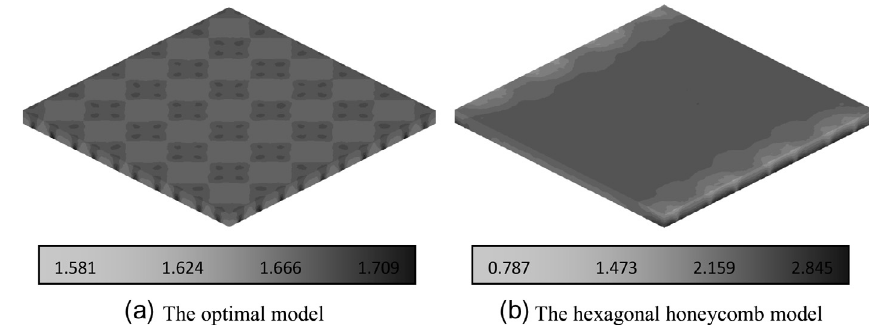
Figure 13. The thermal stress distribution in the ceramic shell under temperature load (Mpa).